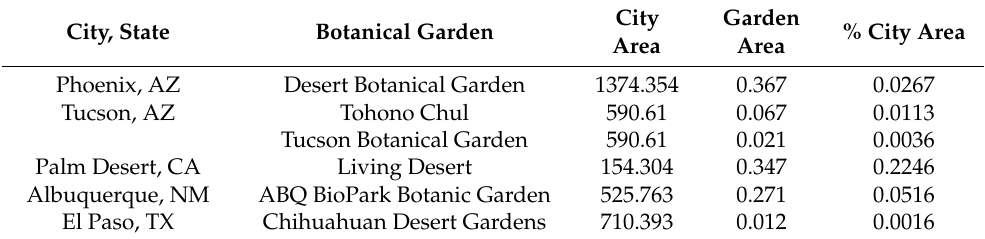
Table 1. Location and areas of botanical gardens included in this study. Areas are measured in square kilometers. The column “% City Area” is the size of the garden relative to the size of the corresponding